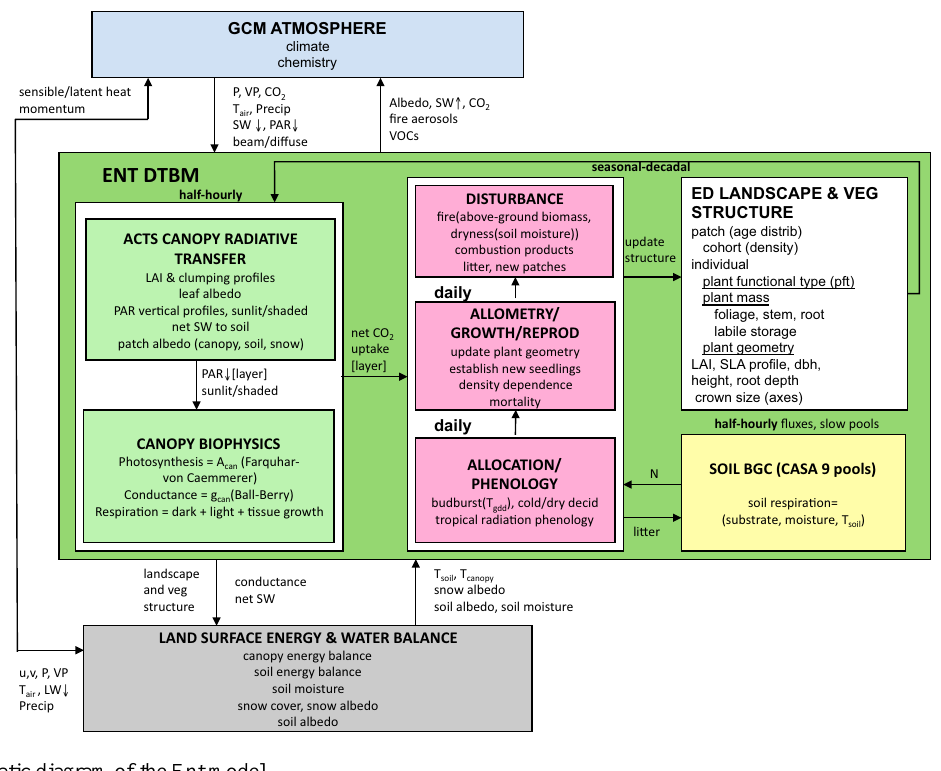
Figure 1. Schematic diagram of the Ent model.